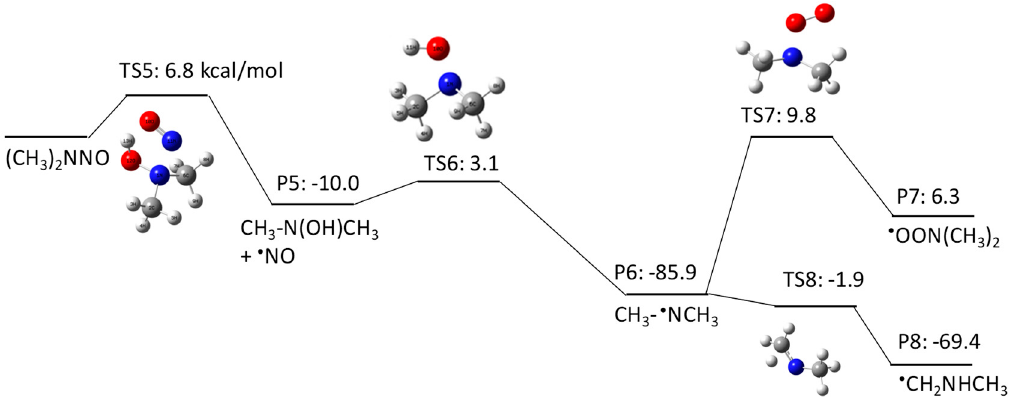
Figure 2. Free energy profile for pathway 1–2 of the HO • -induced reaction pathways for N -nitrosodimethylamine (NDMA) via HO • addition to amine nitrogen. The numbers (kcal/mol) are the free energy of activation for the TS and free energy of reaction for the P relative to the corresponding reactant.